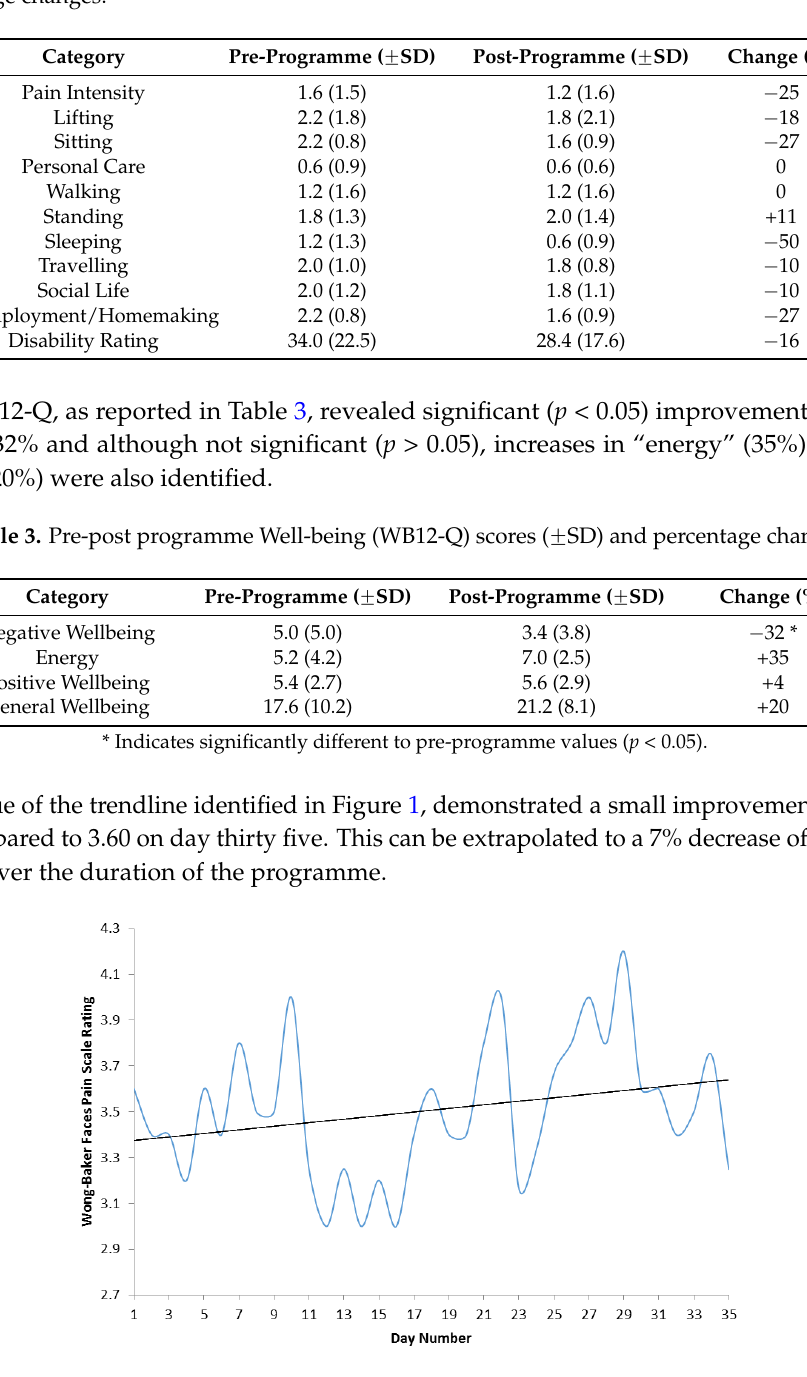
Figure 1. Mean Adapted Faces Pain Scale ratings from day one to day thirty five.